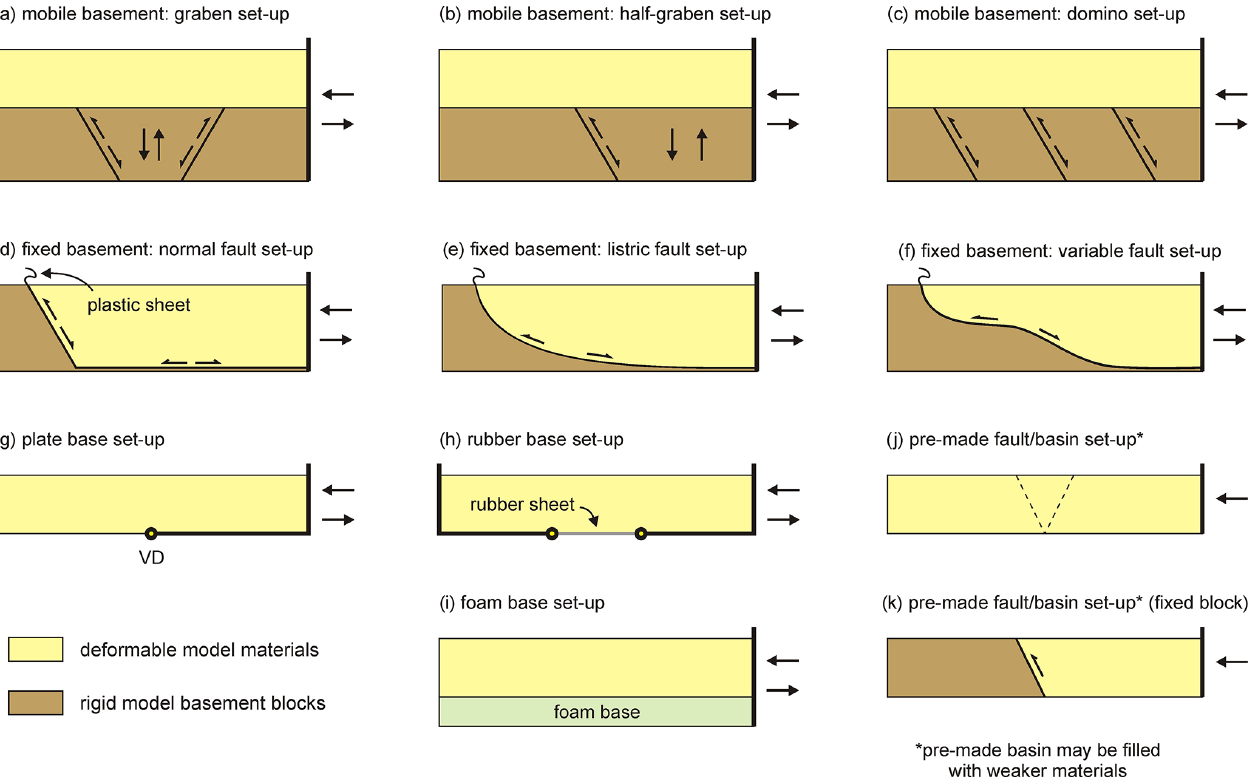
Figure 5. Examples of basin inversion model set-ups illustrated in section view. (a–c) Mobile basement block set-ups. (a) Full-graben set-up. Note that the graben boundary faults can be set to have different dip angles (e.g. Koopman et al., 1987). (b) Half-graben set-up. (c) Domino block set-up (e.g. Buchanan and McClay, 1992). (d–e) Fixed basement (footwall) block set-ups. (d) Steep normal fault set-up (e.g. Buchanan and McClay 1991). (e) Listric fault set-up (e.g. Buchanan and McClay, 1991). (f) Variable geometries of the basement block can also be applied (e.g. McClay, 1995; Ferrer et al., 2016). (g) Plate base set-up, with the edge of the plate base inducing a velocity discontinuity (VD) (e.g. Mitra and Islam, 1994). (h–i) Distributed deformation set-ups. (h) Rubber base set-up, with a rubber sheet spanned between two base plates creating a zone of distributed deformations (e.g. Amilibia et al., 2005). Note that the rubber sheet may also cover the whole base of the model (McClay, 1989). (i) Foam base set-up (e.g. Guillaume et al., 2022; Richetti et al., 2022). (j–k) Pre-made fault or basin set-up,